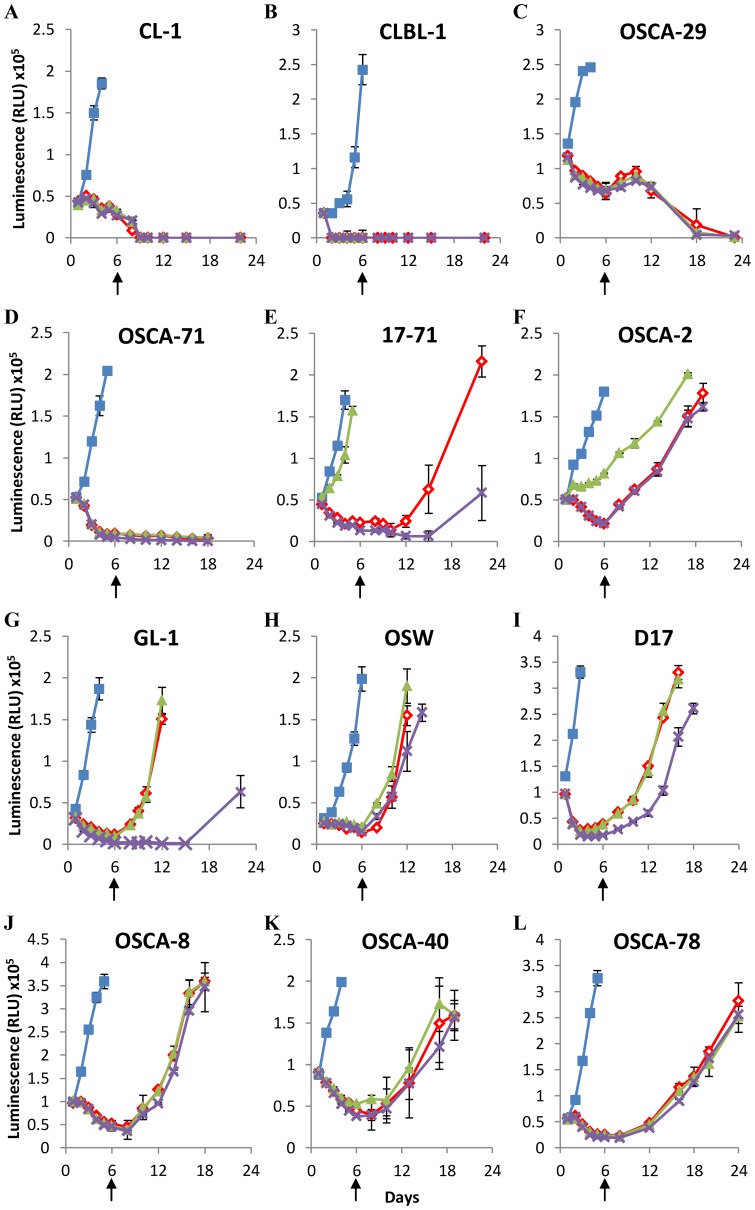
Sensitivity of canine lymphoid cells and osteosarcomas to prolonged arginine-deprivation.Canine lymphoid cells and osteosarcomas (A–L, described in Table 1) were cultured in Arginine-free media for 6 days with the amino acids indicated below. Arginine was reintroduced into cultures on day 6 as indicated by the arrows. Cell viability was determined by ATP quantification. Blue squares = +1 mM Arginine, Red diamonds = Arginine-free, Green triangles = +1 mM Citruline, Purple crosses = +1 mM Ornithine. Graphs show a representative experiment from three independent experiments with similar results. Error bars represent SD.